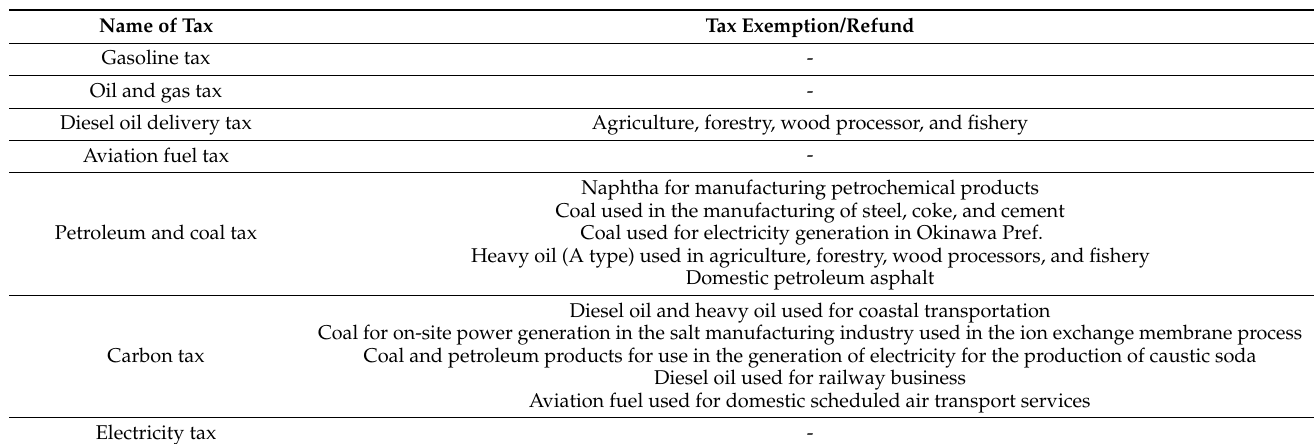
Table 2. Tax exemptions and refunds for energy taxes considered in this